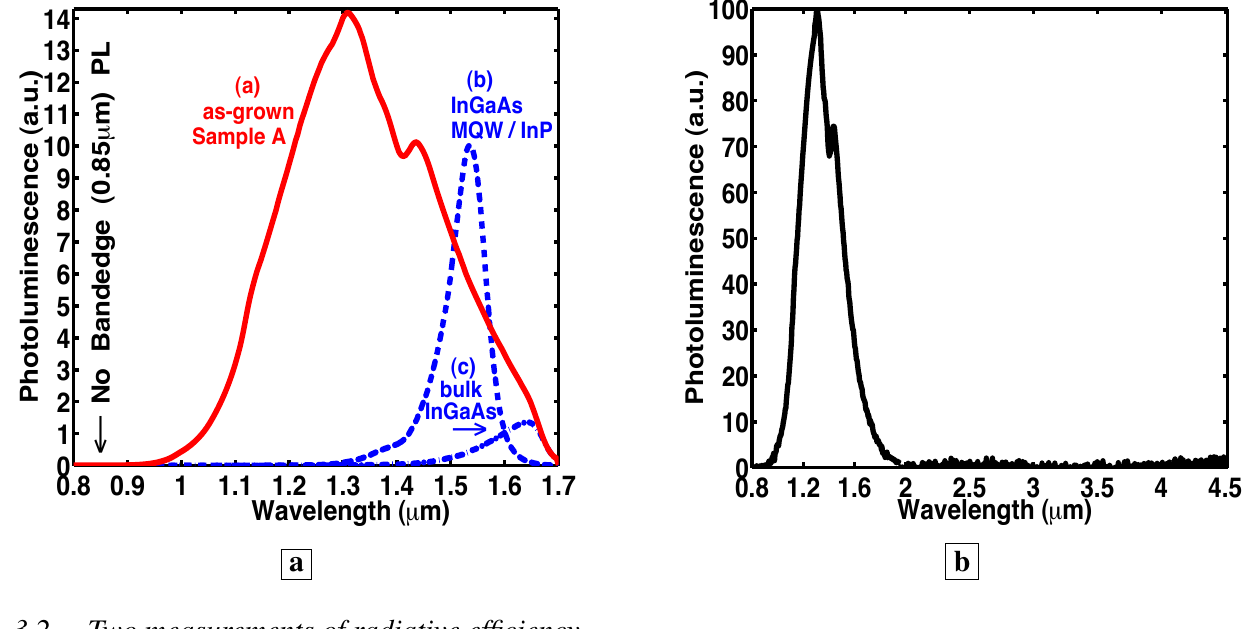
Figure 3 . Room temperature PL [7]. a, PL from GaAs deep-centers and from InGaAs. Curve a shows PL from GaAs deep-centers in Sample A. We calibrated the internal radiative efficiency of these GaAs deep-centers to be about 90%. Curve b shows PL from high-quality InGaAs MQWs lattice-matched to InP. b, PL from GaAs deep-centers over a wide wavelength